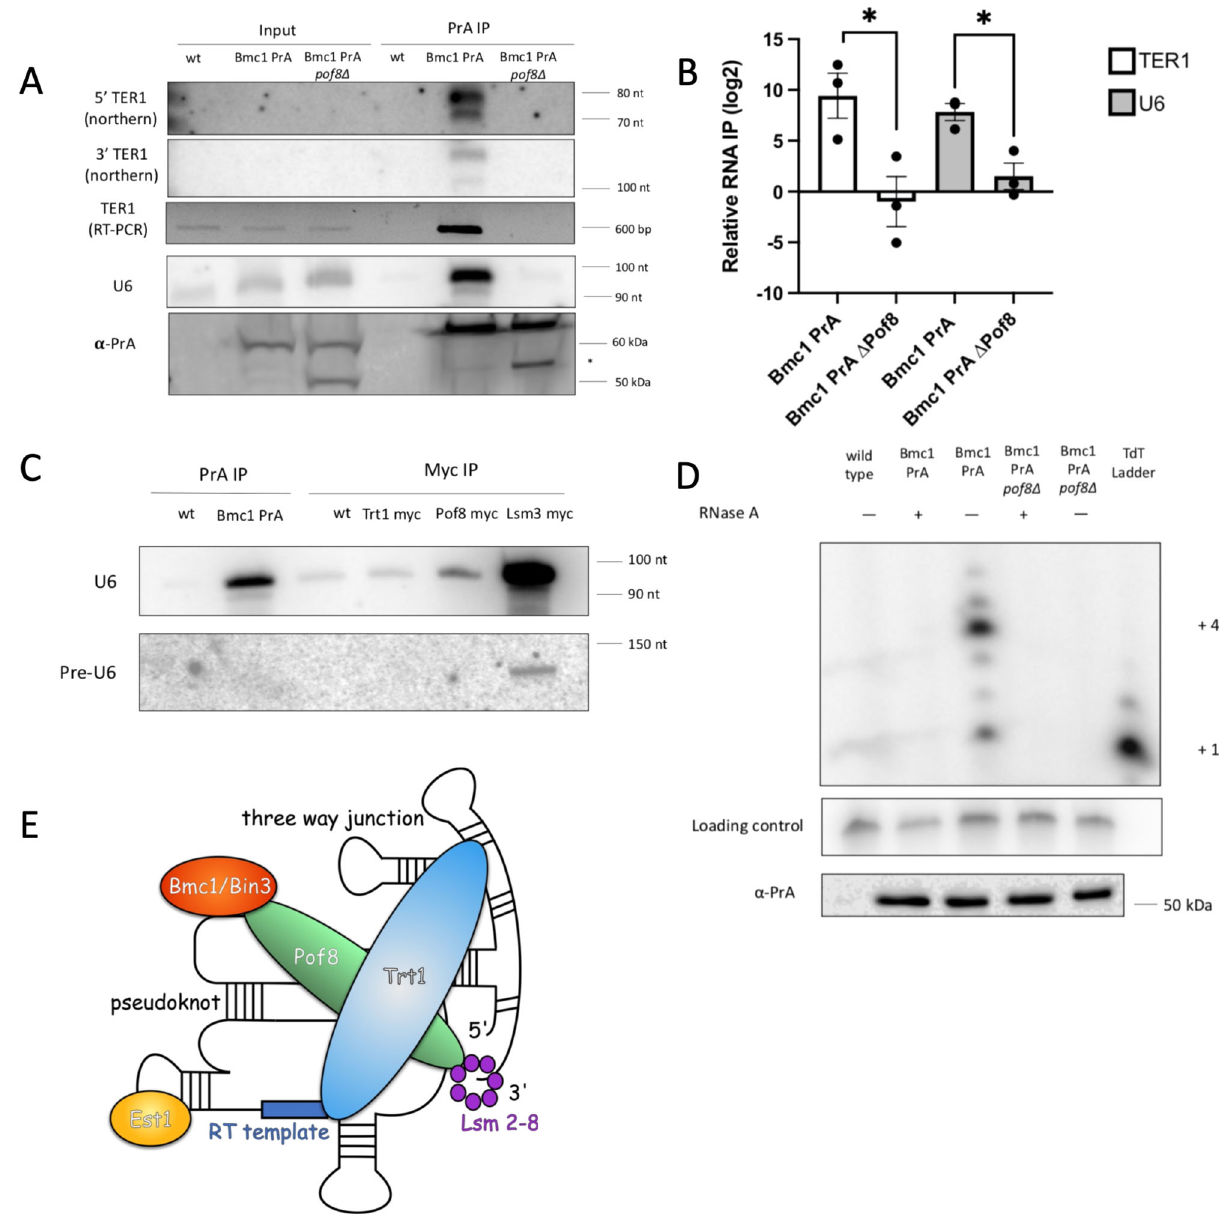
Fig. 4 Bmc1 is recruited to the active telomerase holoenzyme by Pof8. A Northern blot and semi-quantitative RT-PCR of TER1 and U6 in PrA immunoprecipitates for an untagged wild type (wt), PrA-tagged (Bmc1 PrA), and PrA-tagged Pof8 knockout strain (Bmc1 PrA Δ Pof8 ). Bmc1 PrA was detected in input and immunoprecipitated samples by western blots probing for PrA (bottom panel). Possible cleavage products are indicated with an asterisk. B qRT-PCR of TER1 and U6 in Bmc1 PrA immunoprecipitates from wild-type and pof8 Δ strains normalized to input RNA. Relative TER1 and U6 IP was calculated by comparing percent immunoprecipitation of TER1 or U6 to immunoprecipitation from an untagged strain (mean ± standard error, two- tailed unpaired t test * P < 0.05, ** P < 0.01, *** P < 0.001, and **** P < 0.0001) ( n = 3 biological replicates). C Northern blot of mature and intron- containing U6 in PrA- and myc-tagged immunoprecipitated RNA. D Telomerase assay of PrA-tagged Bmc1 in a wild-type and pof8 Δ strain. A 32 P-labeled 100-mer oligonucleotide was used as a loading control. Telomerase extension products were compared to a terminal transferase ladder, with + 1 and + 4 extension products indicated. Western blot probing for PrA following PrA immunoprecipitation is shown in the panel below. E Proposed model of the fi ssion yeast telomerase holoenzyme. TER1 structure and binding locations are based on models constructed by Hu et al. 16 and Mennie et al. 14 . Source data are provided as a Source Data fi